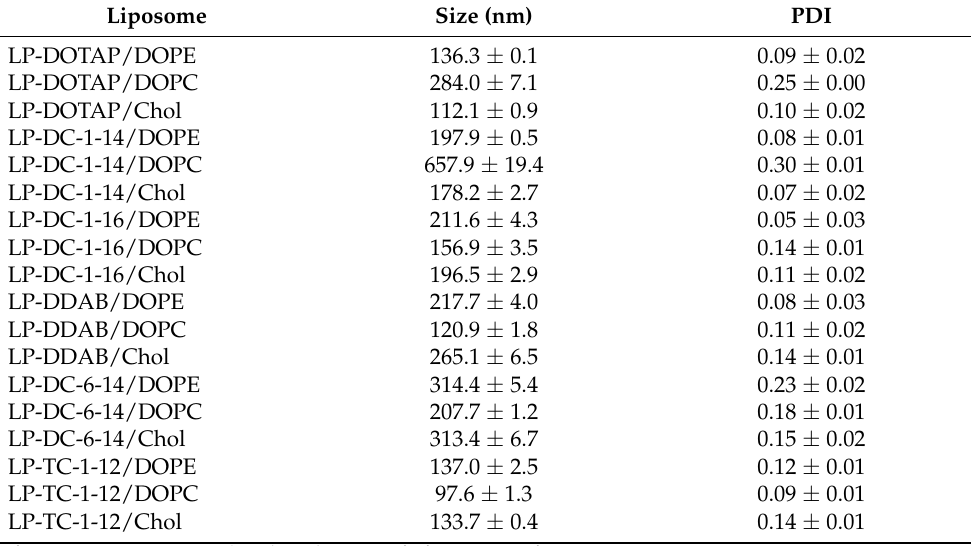
LP-DC-1-16/DOPC 156.9 ± 3.5 0.14 ±